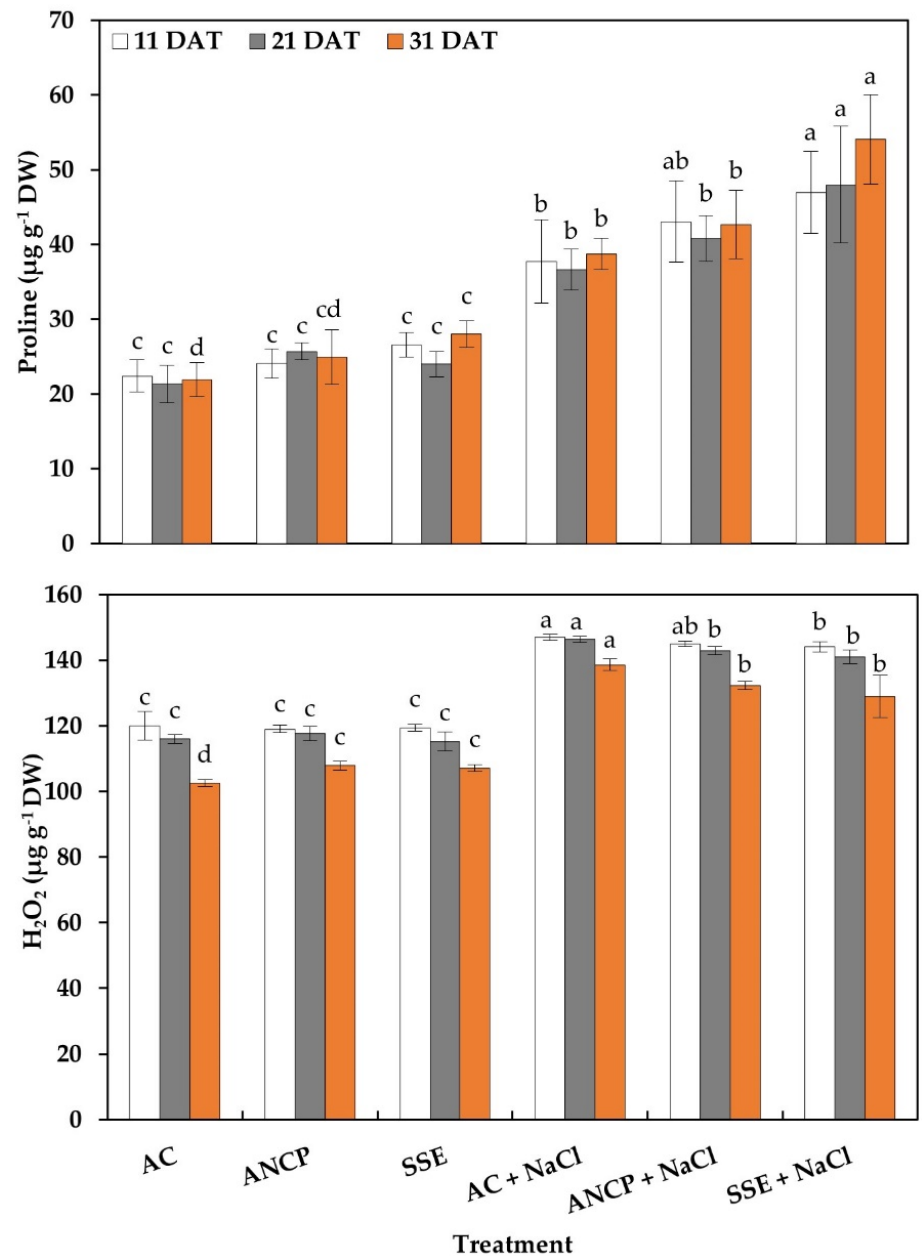
Figure 6. Proline and hydrogen peroxide in the leaves of tomato seedlings. Different letters within each column indicate significant differences between treatments. (LSD, p ≤ 0.05). DAT: Days after transplant; DW: Dry weight; AC: Absolute control; ANCP: A. nodosum commercial product; SSE: Sargassum spp. seaweed extracts; NaCl: 100 mM sodium chloride; n = 5; ± bar intervals represent the SD.